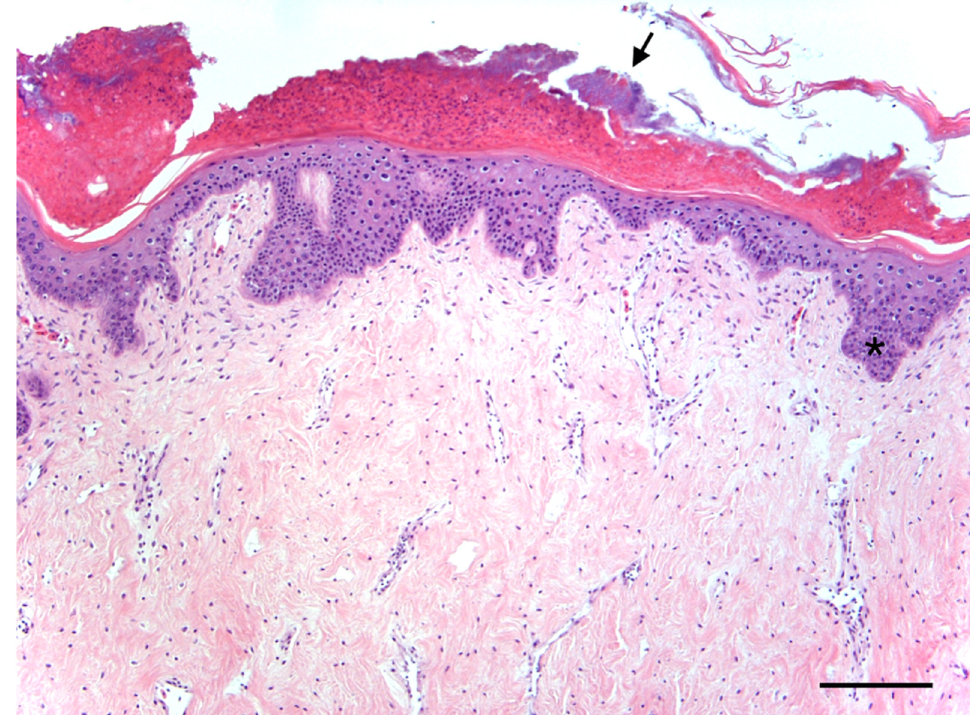
Figure 3. Photomicrograph of a fibropapilloma in a Kemp’s ridley sea turtle ( Lepidochelys kempii ). Histopathological features are diagnostic for this disease and include well-differentiated neoplastic epidermal and stromal components. Short epidermal pegs (*) extend into the underlying dense collagenous stroma, which includes loosely arranged streams and individually dispersed fibroblasts and supportive vessels. A crust of degenerate heterophils with accumulations of bacteria (arrow) is formed on the surface at the top of the image. Hematoxylin and eosin. Scale bar = 200 µm.